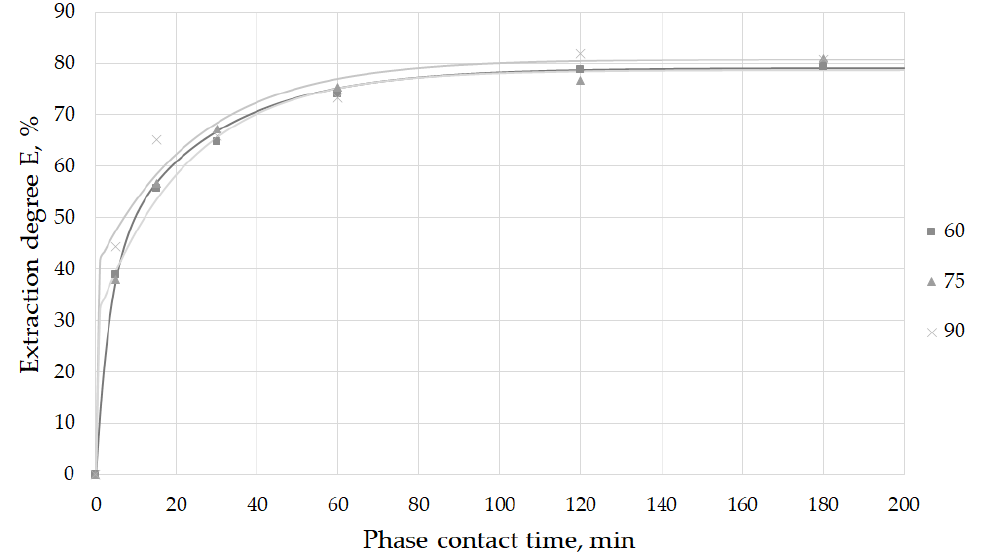
Figure 11. The dependences of the yttrium extraction degree on the phase contact time at different shaking frequencies during the solid–liquid extraction process.